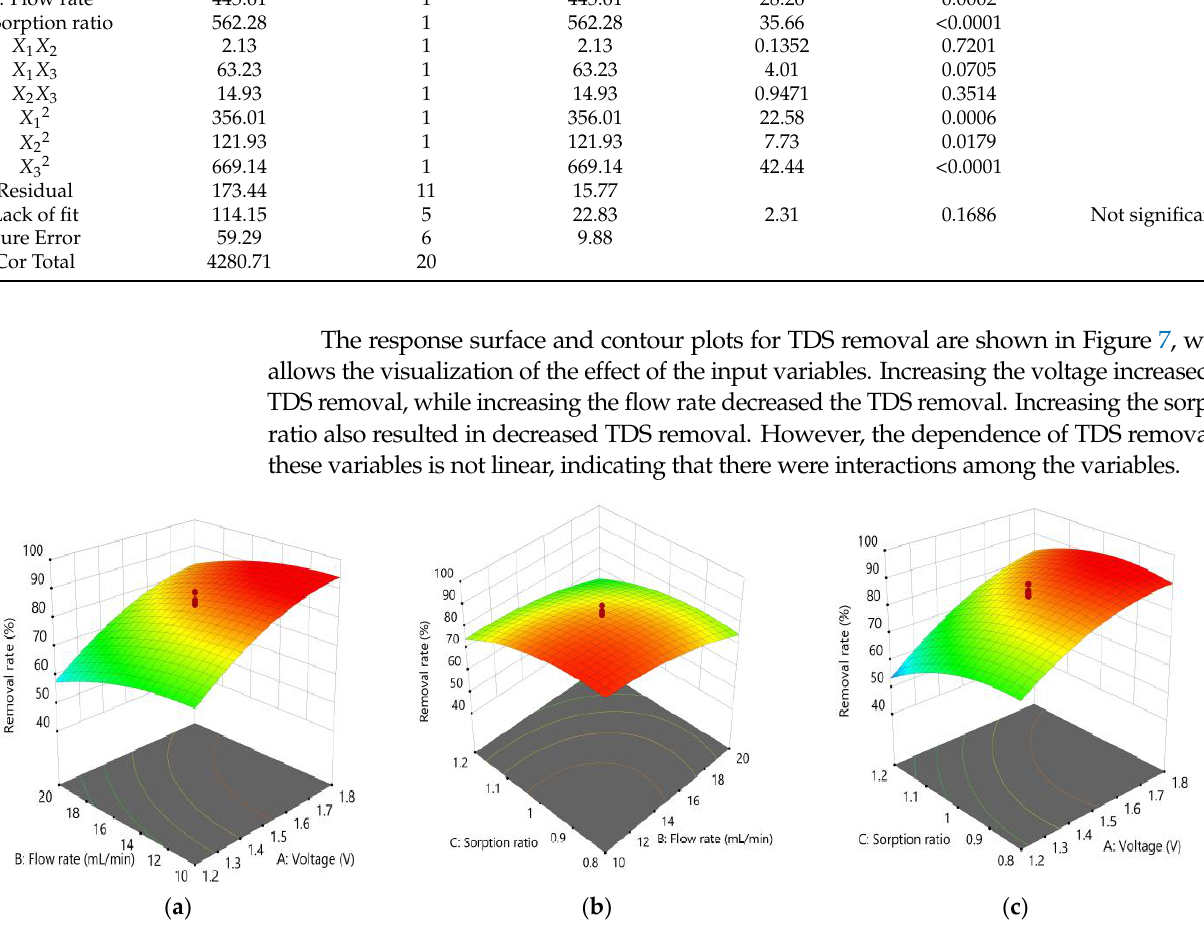
Figure 7. 3D response surface plots showing the effects of the three main factors on TDS removal using the CDI: ( a ) voltage and flow rate; ( b ) flow rate and sorption ratio; ( c ) voltage and sorption ratio.